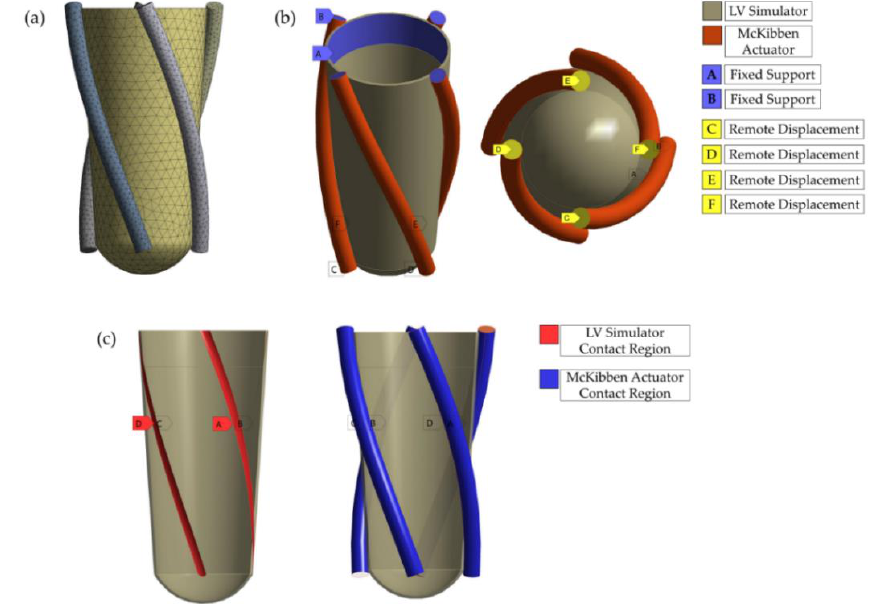
Figure 3. The 90 degrees orientation model is given as an example; ( a ) Meshed geometry with tetrahedral elements; ( b ) Fixed supports were defined on the LV simulator and the McKibben actuators. Remote displacements were added to the bottom surfaces of the actuators with rigid behavior; ( c ) Continuous contact region was defined on the surface of the slot of LV simulator and the surface of the actuators.